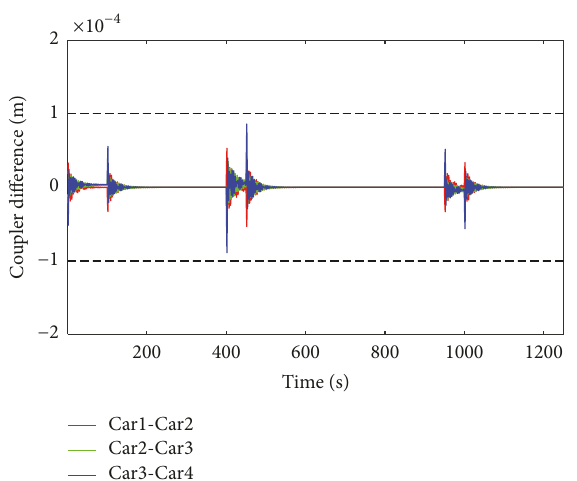
Figure 6: The coupler deformation between neighboring cars.